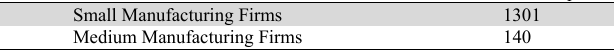
Sample Proportion among Small and Medium Firms